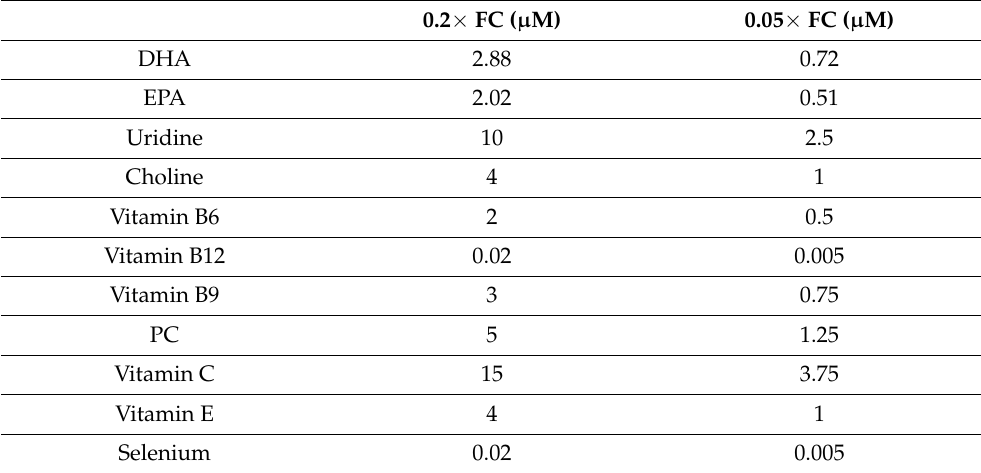
Table 1. FC composition. Final concentrations of FC components ( µ M) for the two conditions: 0.2 × FC (high dose) and 0.05 × FC (low